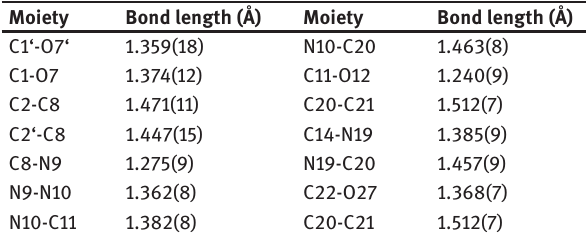
Table 2: Selected bond lengths of H-HHAQ.